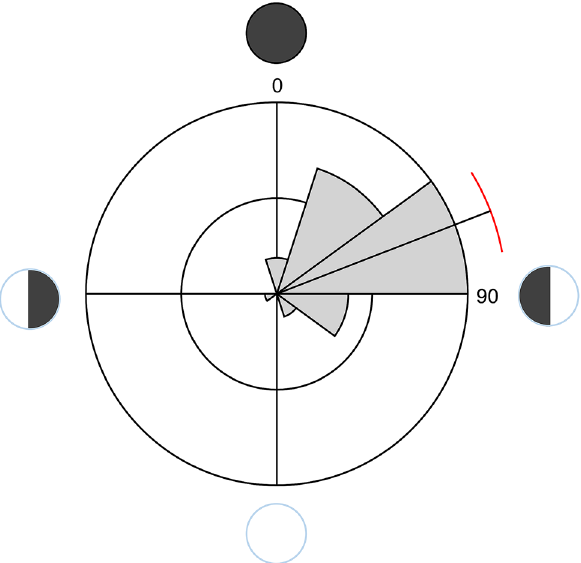
Figure 3. Distribution of hatch frequencies of LDF Schindleria from the Red Sea along a lunar cycle (indicated with the four different black and white pie charts). The new moon corresponds to 0° (top), the 1st quarter moon to 90° (right), the full moon to 180° (bottom), and the 3rd quarter moon to 270° (left). The “black” line gives the angular mean and the “red” arc the angular variance of the data and the pie sections within the circle, the number of hatch events during those lunar days.